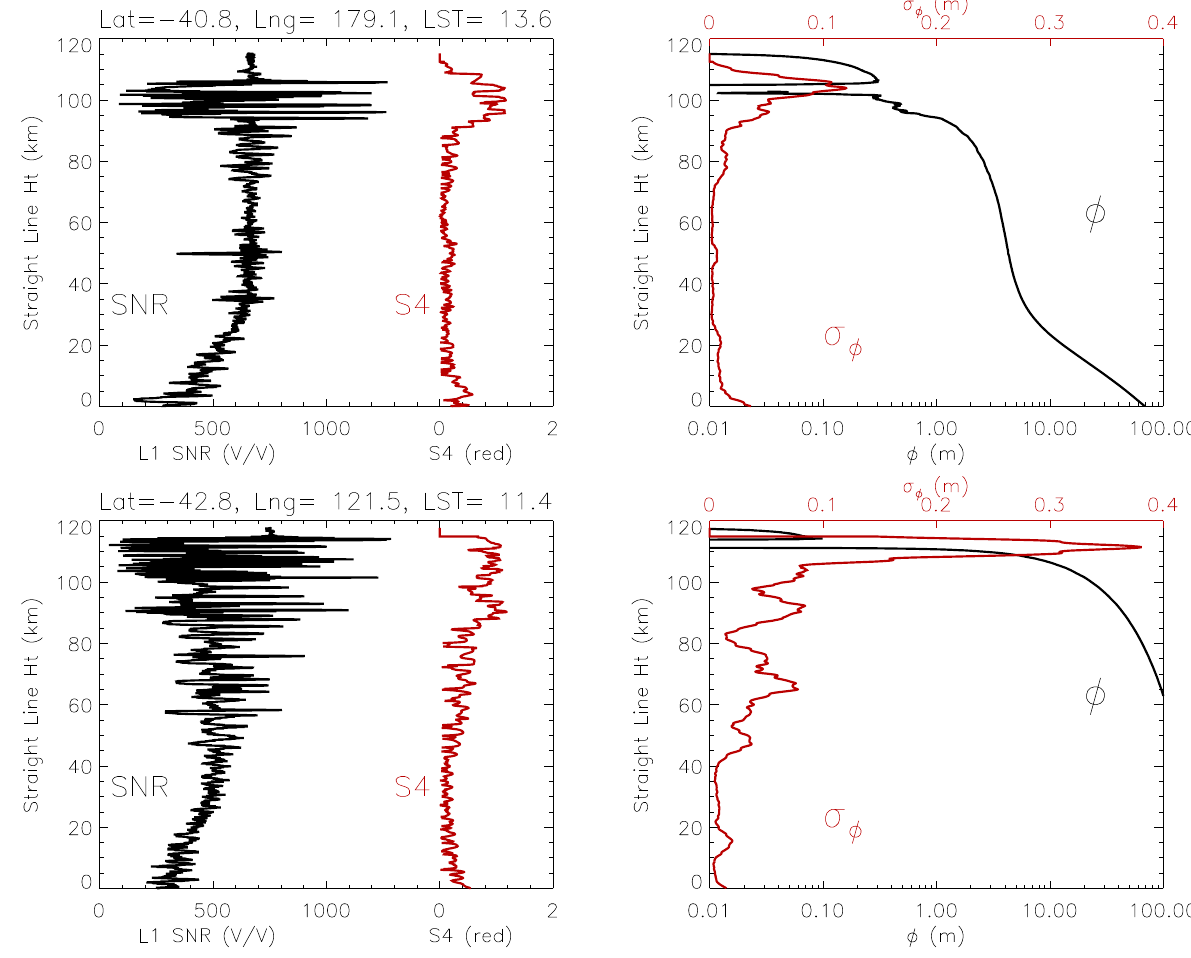
Figure 1. Two GNSS-RO scintillation examples from COSMIC-1 measurements on 2 Jan- uary 2008 (atmPhs_C001.2008.002.01.42.G29_2013.3520_nc on top and atmPhs_C001.2008.002.03.21. G10_2013.3520_nc on the bottom), showing the saturated S 4 with largely different σ φ in the E-region. φ and σ φ represent the L 1 phase measurement and its scintillation, respectively. LST refers to Local Solar Time, Lat is the latitude, Lng is the longitude, and the Straight Line Ht is the straight line tangent altitude